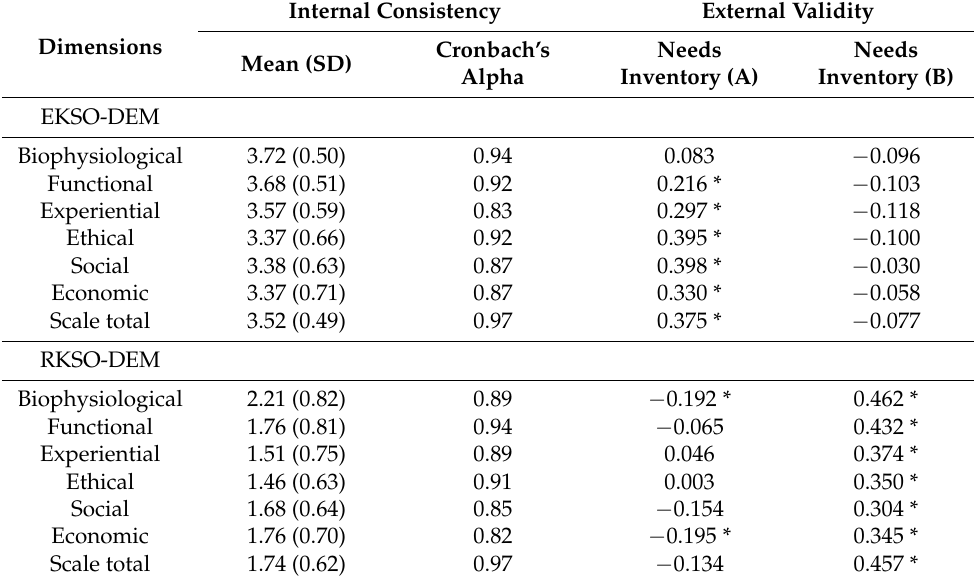
Table 5. Internal consistency and external validity.